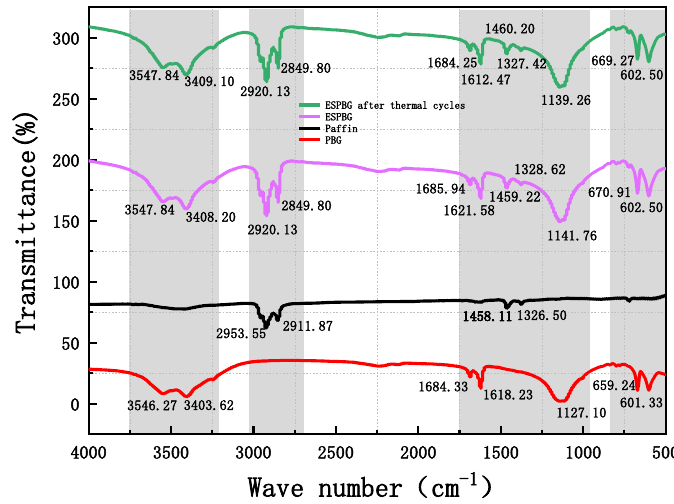
Figure 14. Infrared spectra of the PBG, paraffin, ESPBG, and ESPBG after thermal cycling. Table 7. Characteristic absorption peaks of the FTIR spectra of PBG, paraffin, ESPBG, and ESPBG after thermal